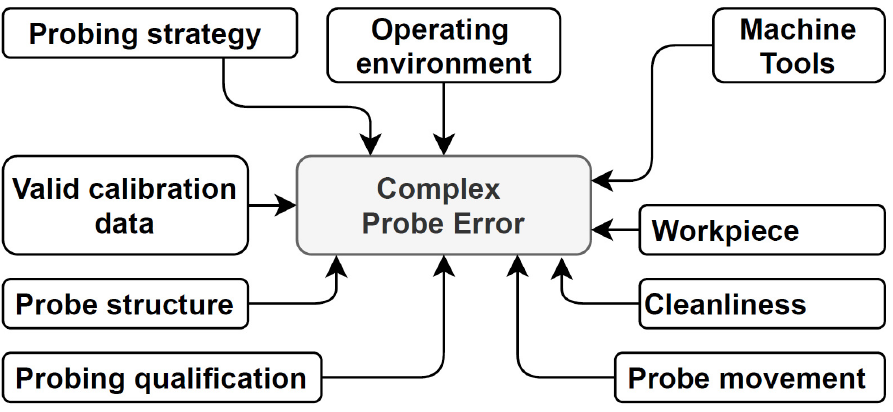
Figure 2. Items for probing error budget of on-machine measurements [13,25–27].